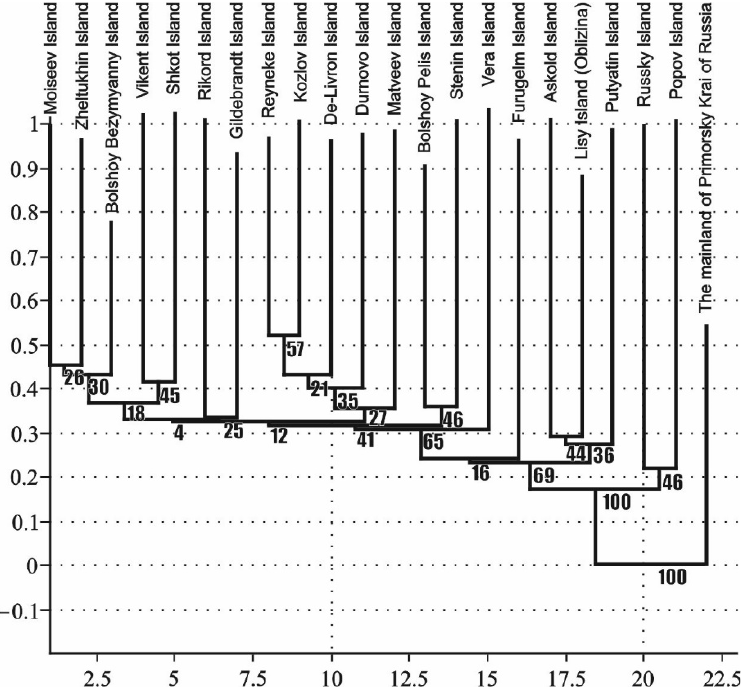
Figure 4. Dendrogram of the similarity of the local faunas of Scarabaeoidea of the islands of the Peter the Great Gulf with the mainland of the Primorsky Krai of Russia.